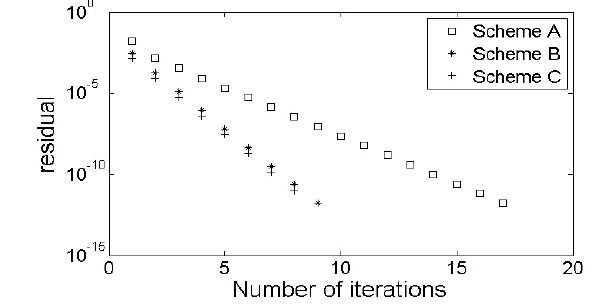
Figure 4. Residual convergence with the three refinement schemes in the Astrophysics